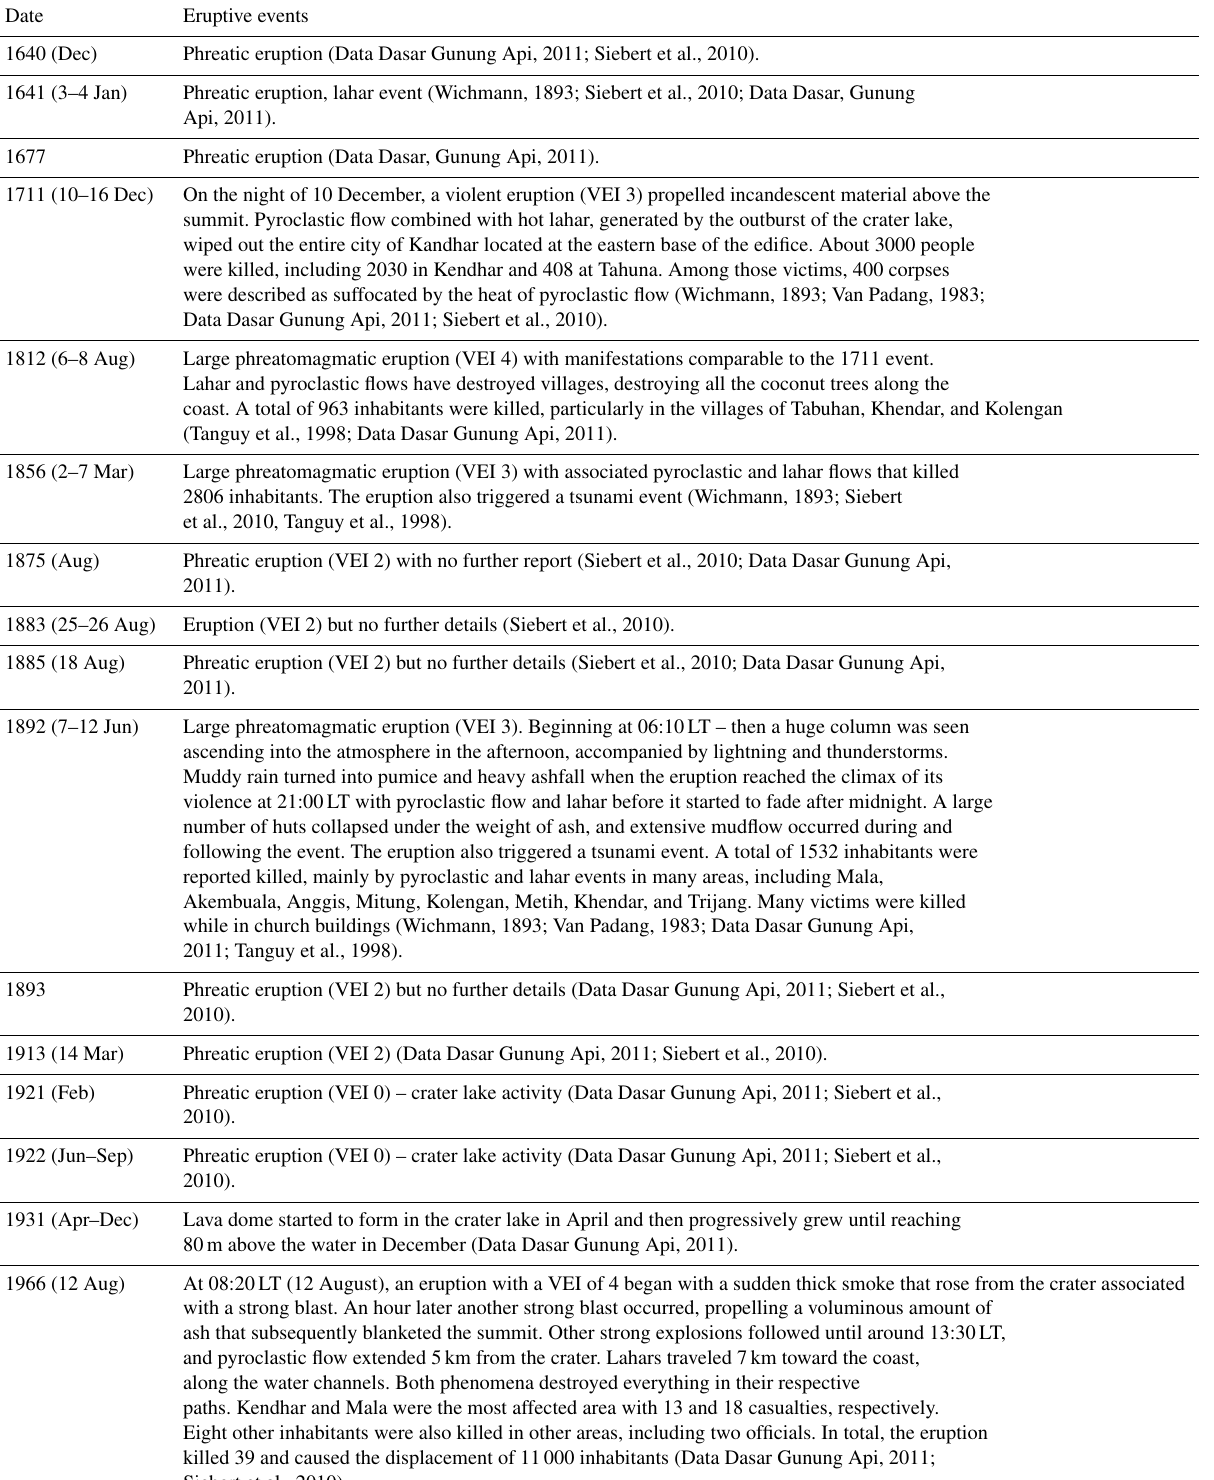
Table 1. History of Awu eruptive activity. Most of the information is obtained from Data Dasar Gunung Api (2011) and Siebert et al.